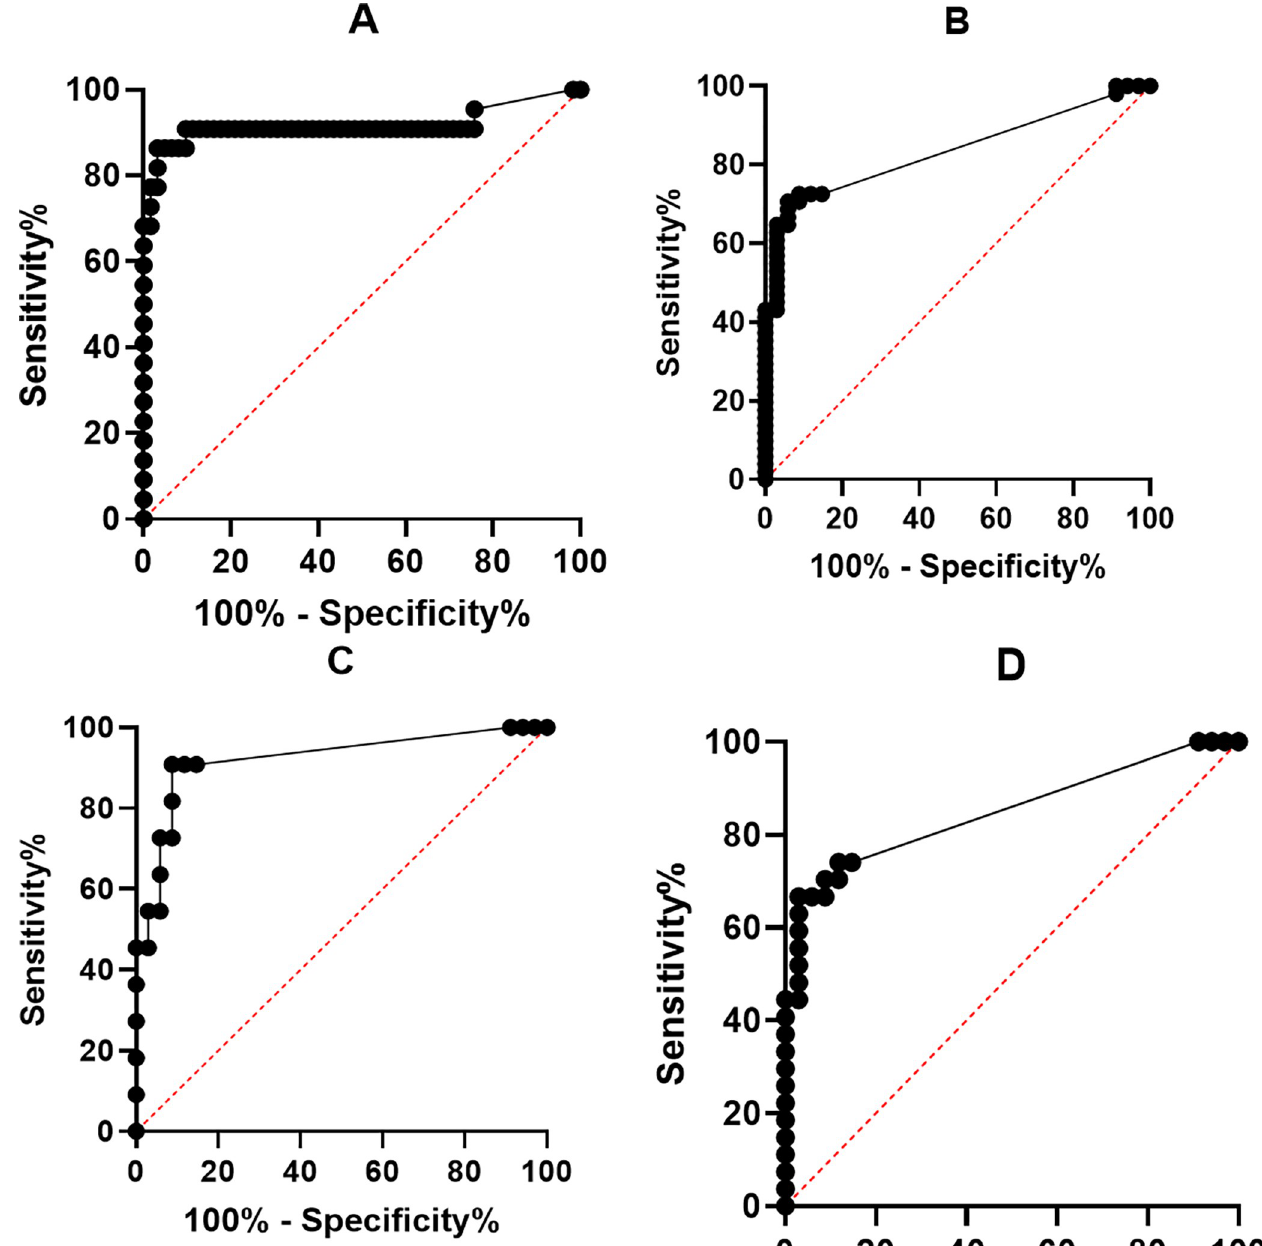
Fig 2. ROC curves for PTX3 diagnostic abilities. A) Bacterial meningitis versus Viral meningitis and Viral encephalitis. B) Viral meningitis versus Control group. C) Viral encephalitis versus Control group. D) Lyme disease versus Control group. https://doi.org/10.1371/journal.pone.0282004.g002 In comparison with studies of other biomarkers, we find PPV and NPV for CSF PTX3 com- parable to known used biomarkers, including CSF cell count, CSF polynuclear cell count (PNC), and CSF protein concentration. We found PTX3 to be non-detectable or very low in the CSF in a control group despite clinical suspicion of meningitis and other inflammatory activity as indicated by elevated CRP and leukocytes in the blood. Our findings suggest that PTX3 does not cross the blood-brain barrier in patients without inflamed meninges, albeit we